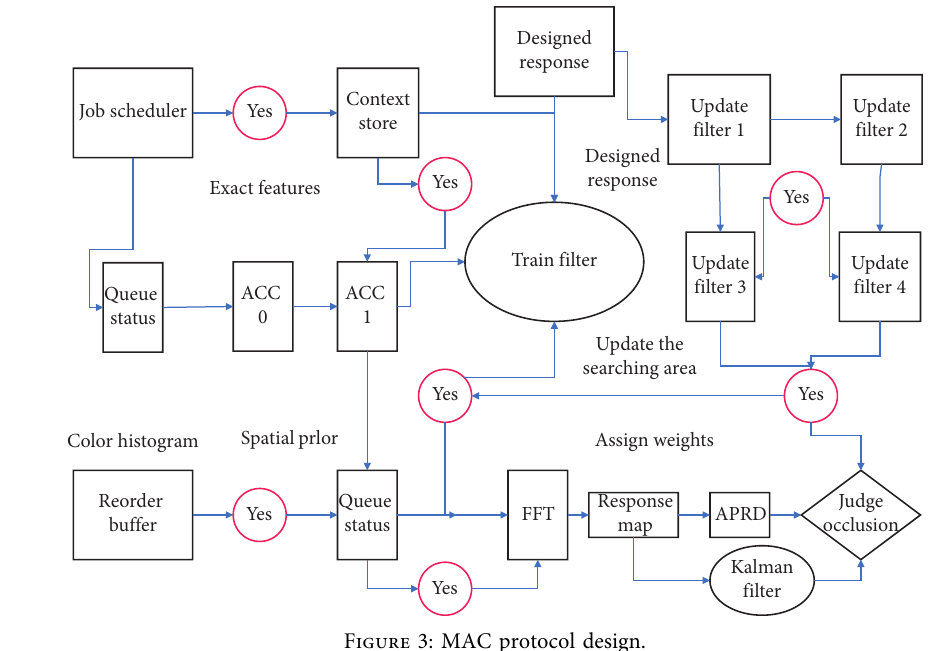
Figure 3: MAC protocol design.